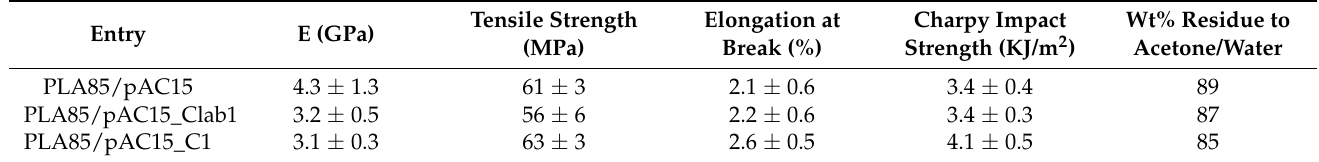
Table 2. Mechanical and impact properties of the PLA85/pAC15 blends compounded with Clab1 and C1.